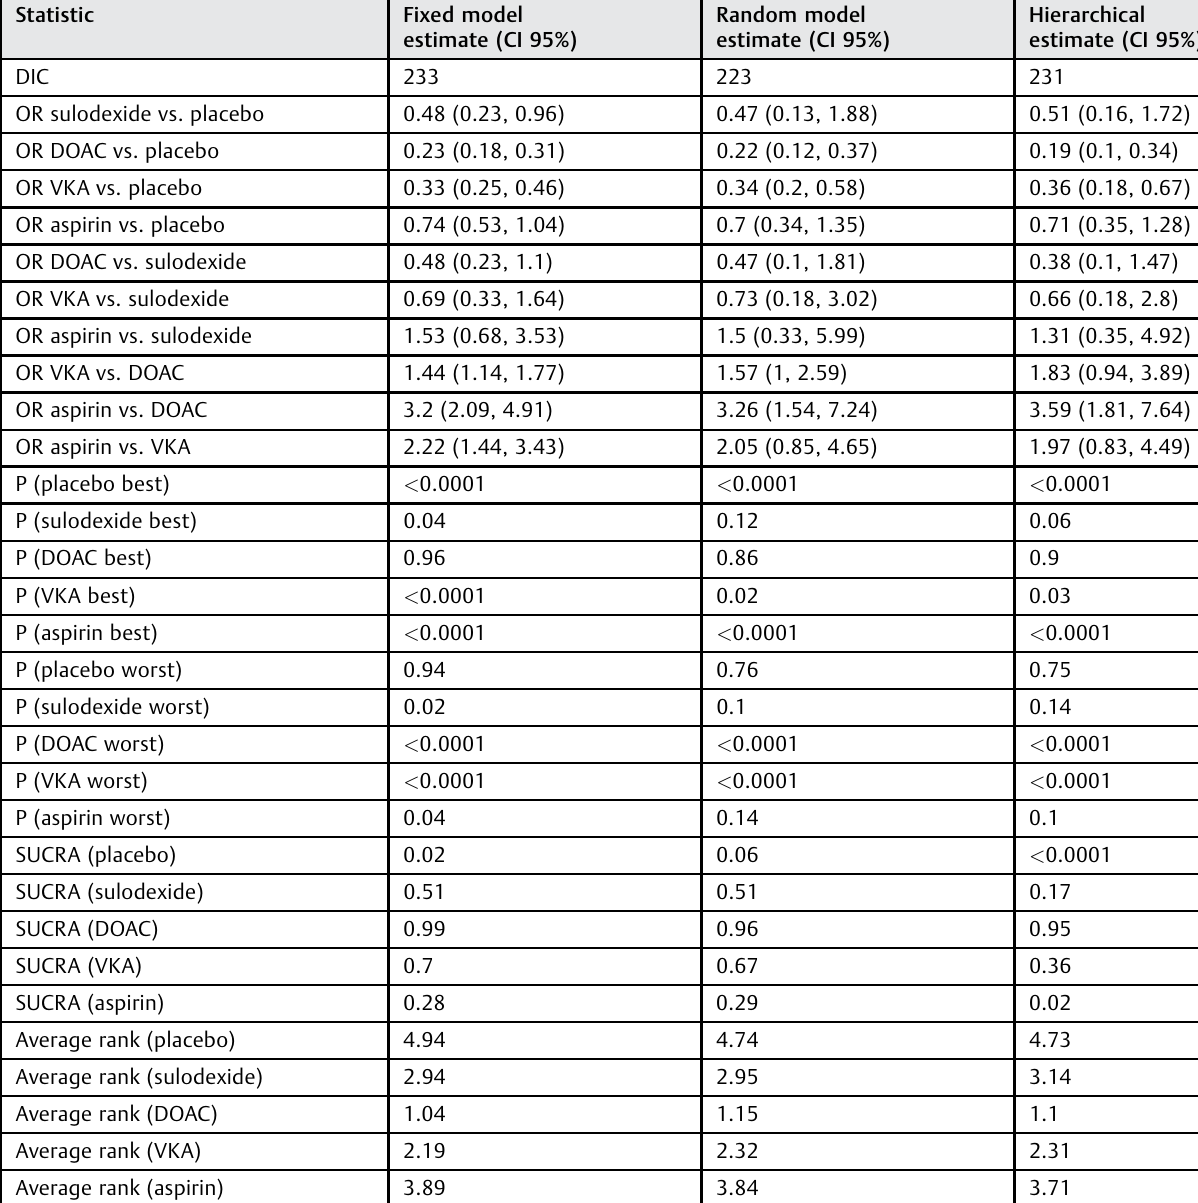
Table 1 Main results for r-DVT, all studies Statistic Fixed model